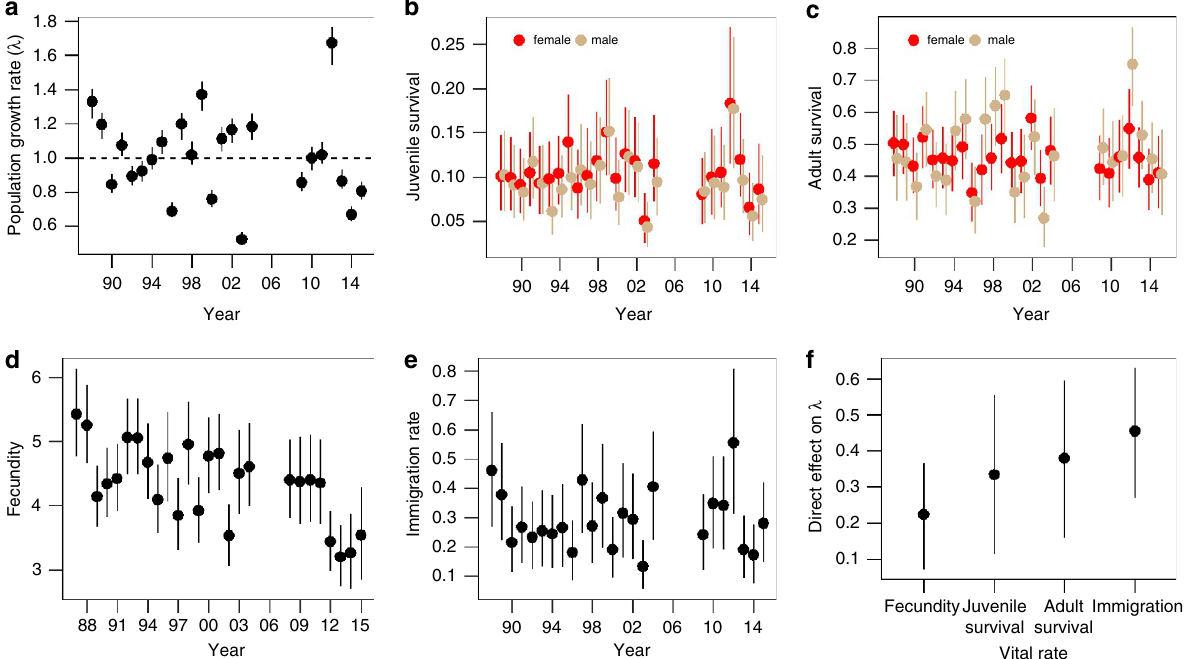
Figure 3 | Vital rates and their contributions to variation in population growth rate. Annual estimates (mean ± 95% credible interval) of ( a ) population growth rate, sex-specific ( b ) juvenile and ( c ) adult survival, ( d ) fecundity and ( e ) sex-specific immigration rates for Savannah sparrows from a breeding population on Kent Island, NB, Canada (Fig. 1b). ( f ) Direct effects of variation in juvenile survival, adult survival, fecundity and immigration rate on population growth